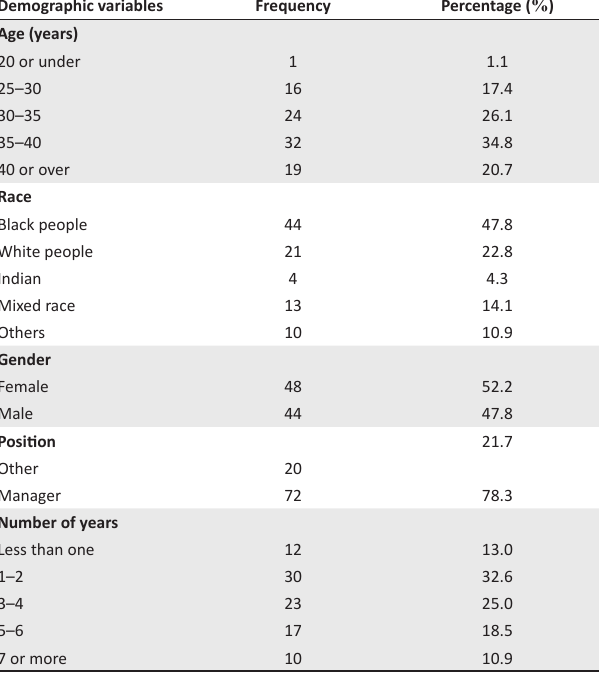
TABLE 1: Demographical information. Demographic